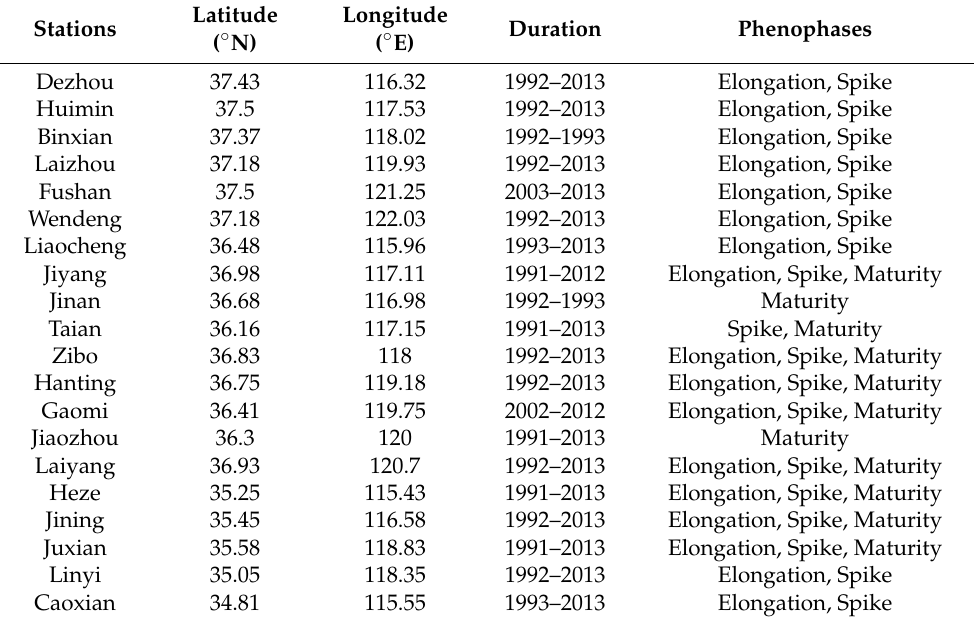
Table 1. Basic information of phenology observation